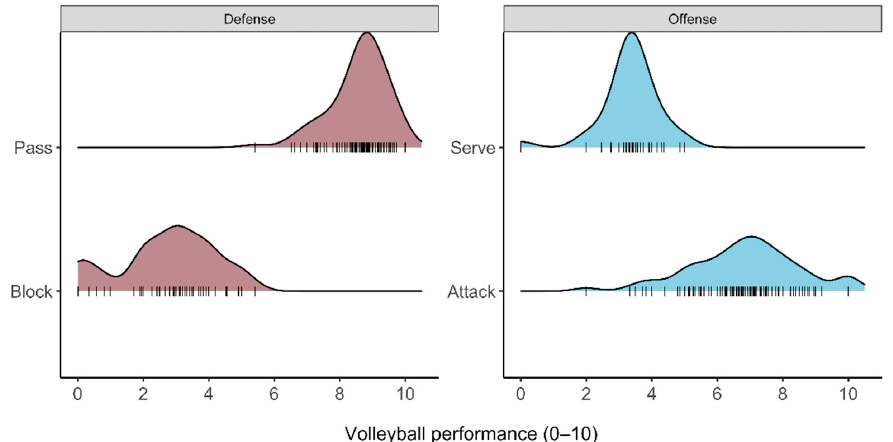
Figure 3. Distribution of scores for the considered volleyball actions. Defensively, the scores for pass actions are usually higher than the scores for block actions. Higher offensive scores are observed for attacks than for services.